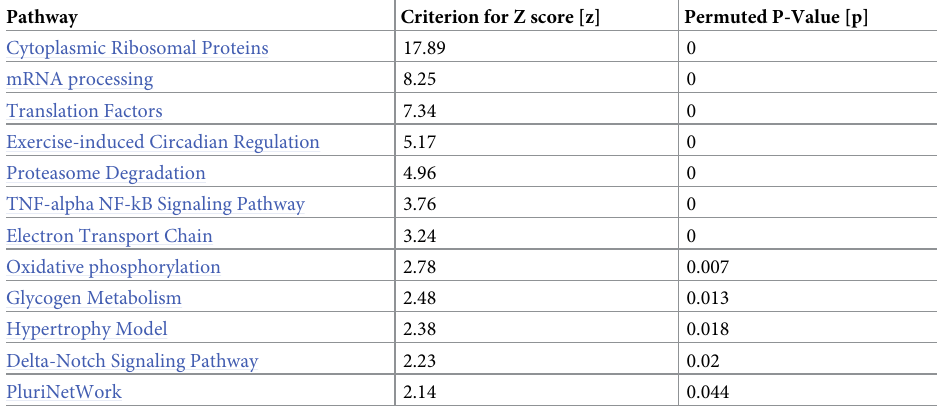
Table 3. Pathway statistics: G3_SGE+BEV_vs_SGE, fold change > 4. Pathway Criterion for Z score [z]